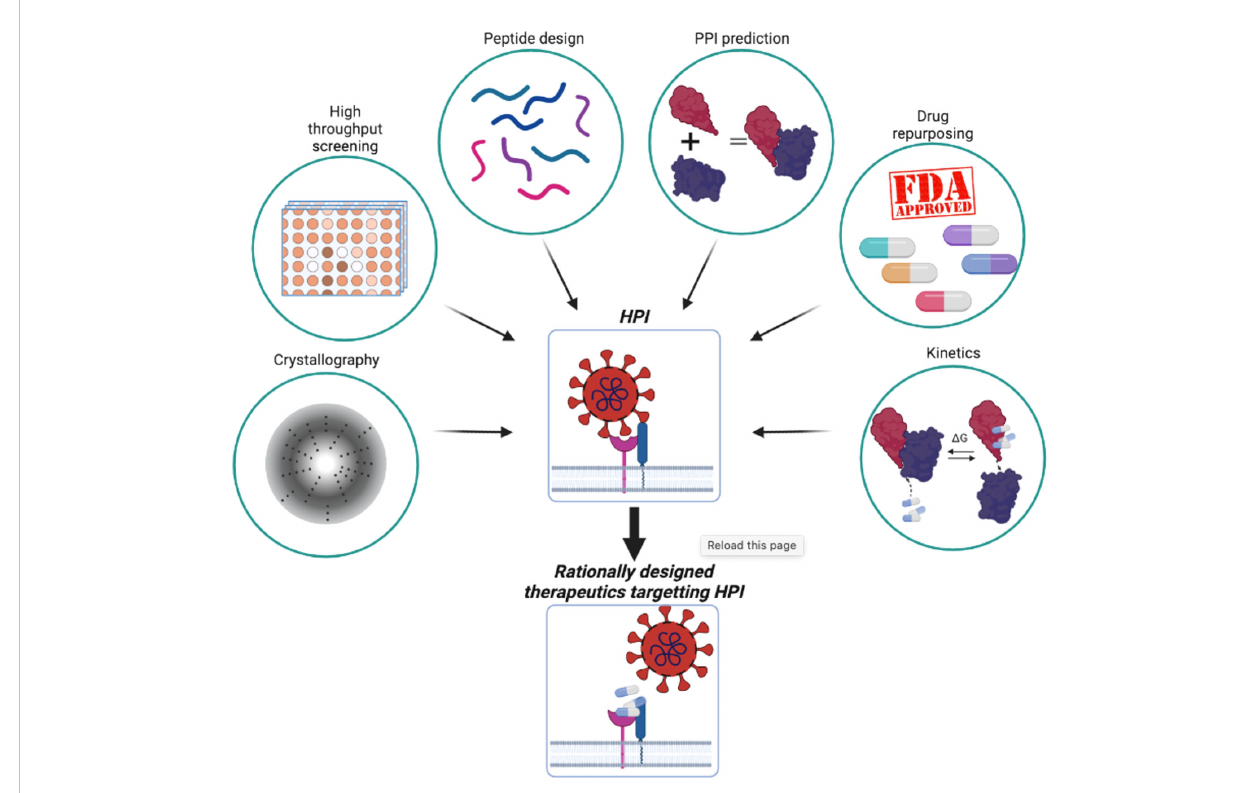
FIGURE 2 Combination of experimental and in silico methods aids rational therapeutics design to target